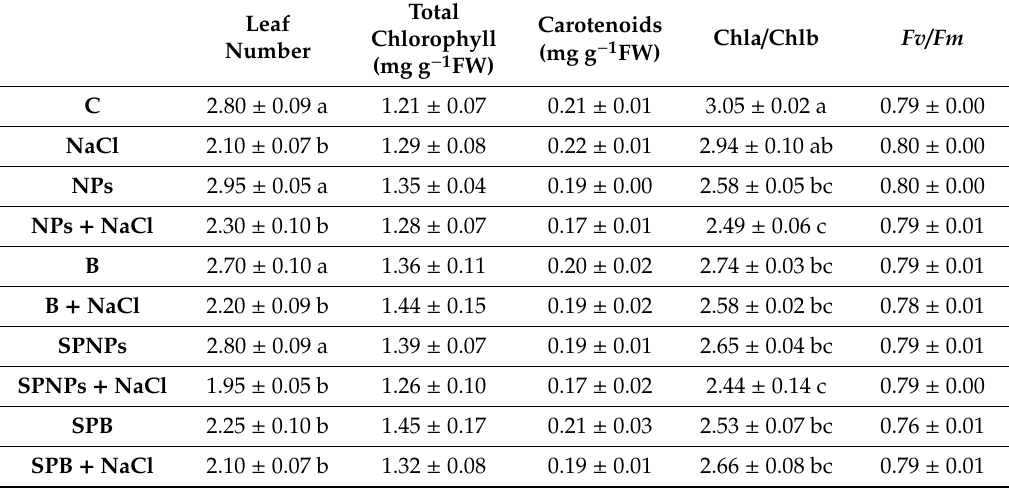
Values are means of at least three replicates ± SE. When ANOVA highlighted significant differences, Tukey’s post hoc test was performed, and different letters indicate significantly different mean values at p < 0.05.